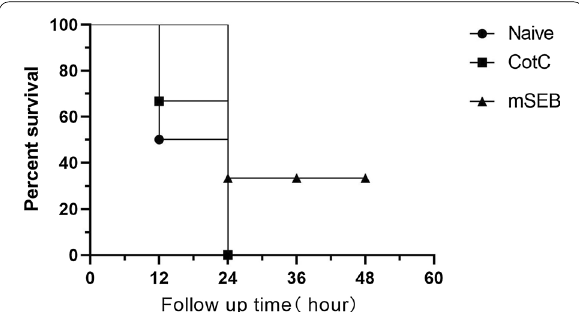
Fig. 7 Survive rates in mice after SEB challenge. Two weeks after the last oral administration of mSEB spores, mice were challenged intraperitoneally with 5 µg SEB and 25 µg LPS, and the survive rates were recorded in 12, 24, 36, 48 h to determine the protection efficacy of mSEB